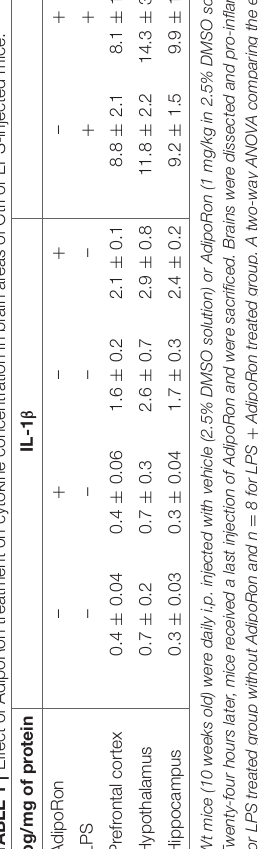
of gApN on microglia are predominant compared to the pro-inflammatory ones on astrocytes. This is also true when examining the in vivo global effects of gApN on diverse brain regions such as hippocampus, hypothalamus or amygdala ( Figure 1 ). The role of microglia and astrocyte crosstalk